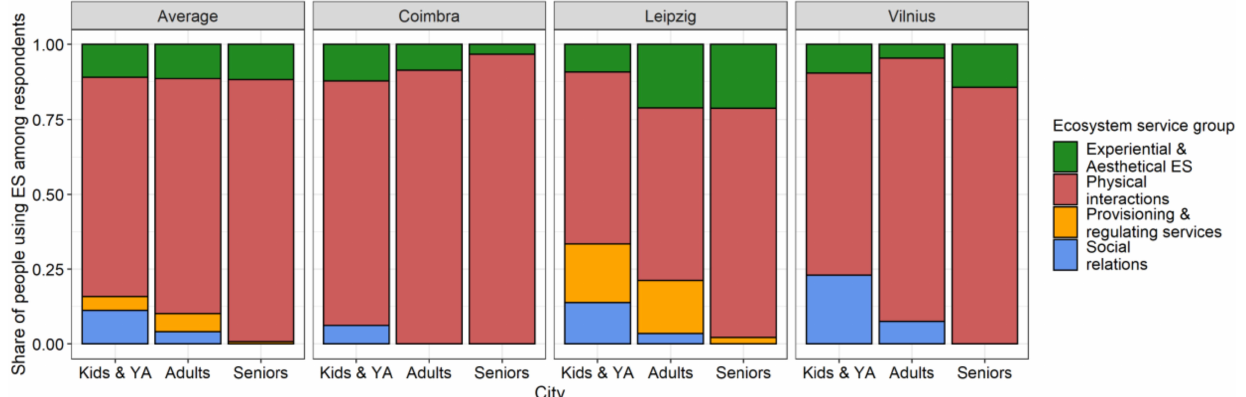
Figure 2. Share of ecosystem service group uses per